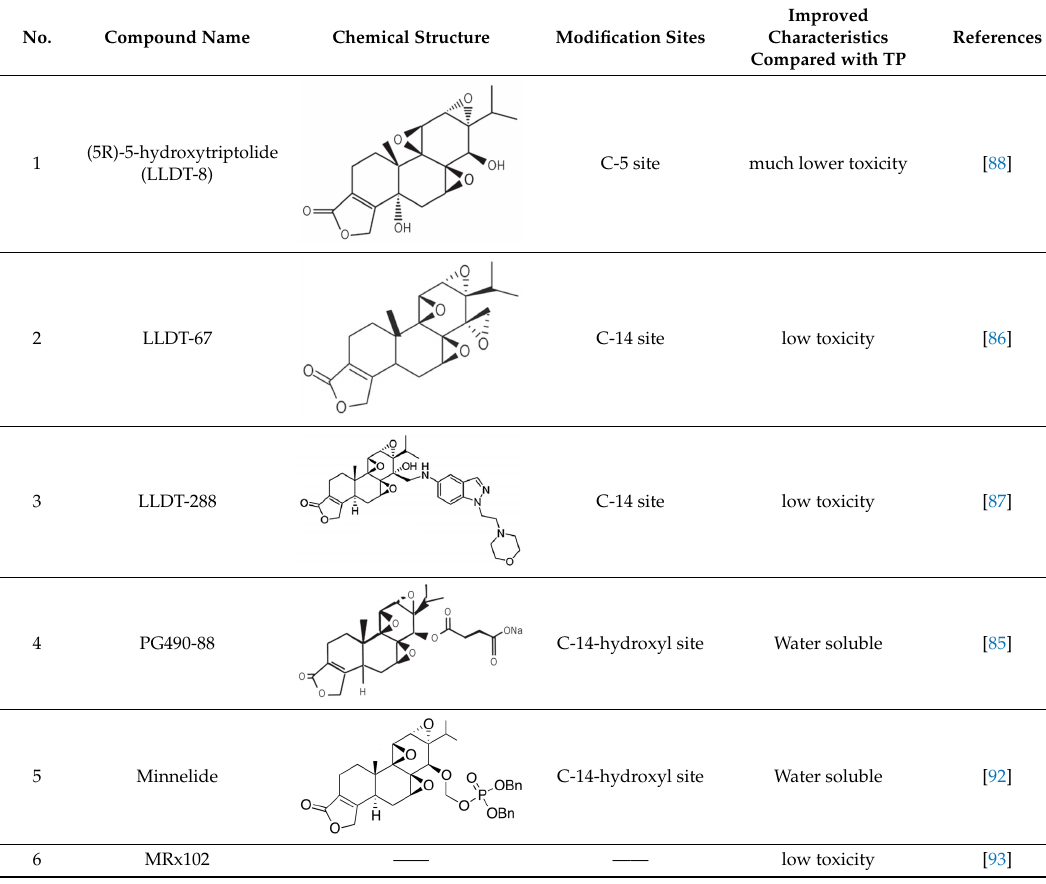
Table 1. Main derivatives of TP.